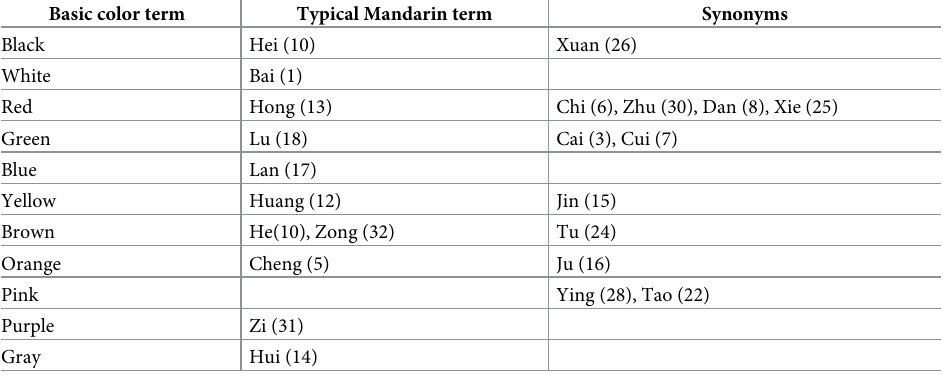
Table 2. Basic color categories, denoted by basic color terms, and their typical terms and synonyms in Mandarin Chinese. The number in each parentheses is the sequence number of each word in Table